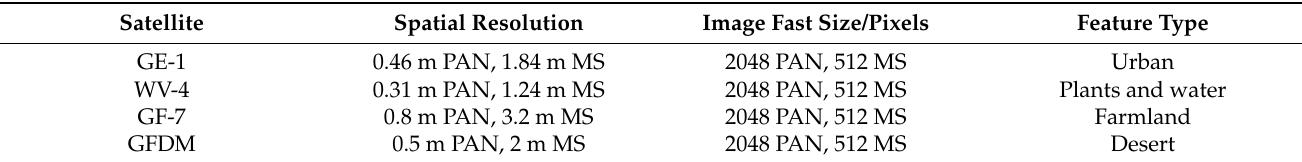
Table 1. Experimental datasets.